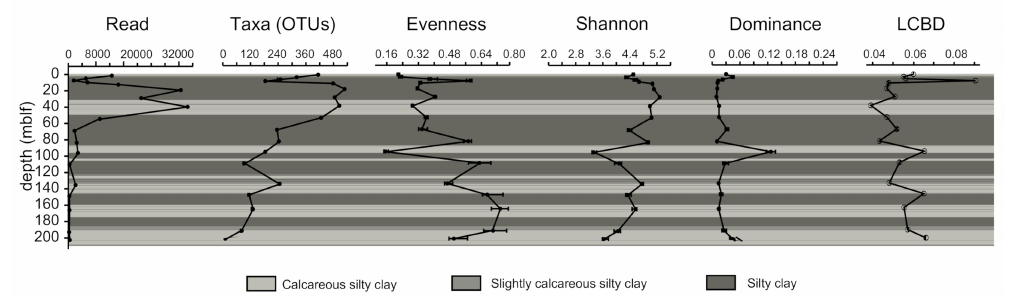
Figure 4. Diversity profiles including sequencing read number, OTU number, OTU richness, Shannon diversity index, evenness and local contribution to beta-diversity (LCBD) along the core (for OTUs defined at 97%), with corresponding sedimentary facies as described by Francke et al. (2016).